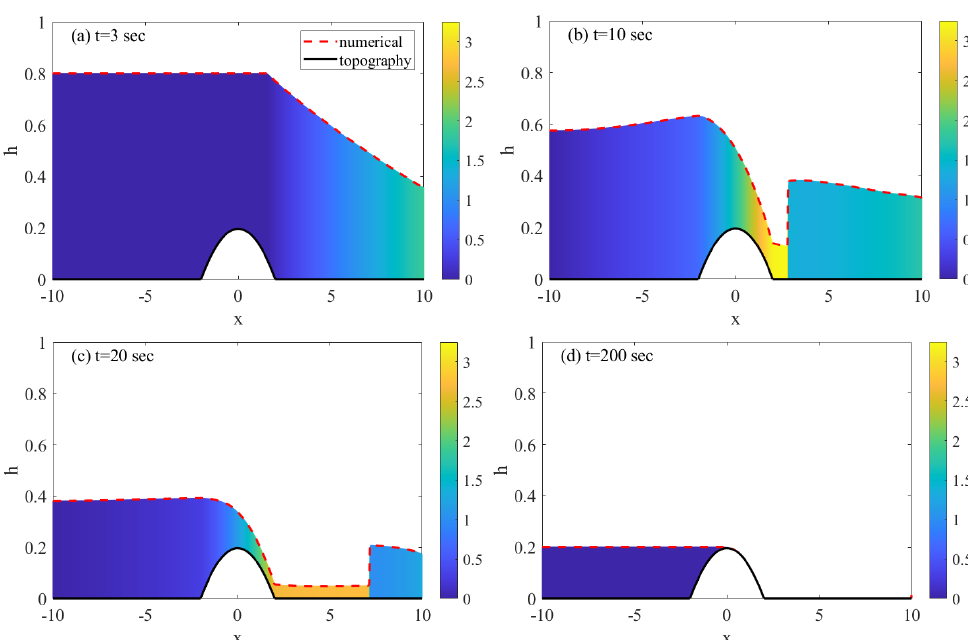
Figure 7. Plot the surface h ( x , t ) at subsequent times of a drainage simulation in a channel with a bump and contraction. The color scale indicates the horizontal velocity of u ( x , t )